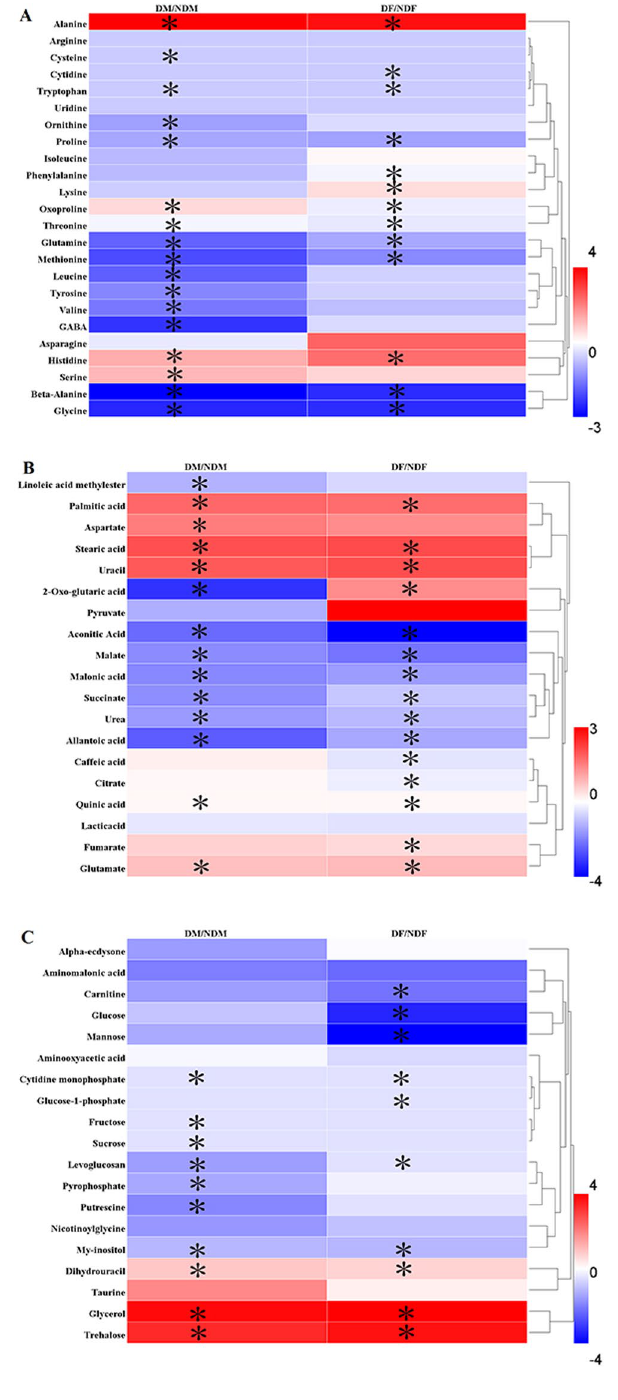
Figure 3. Comparison of the C. ciliata adults metabolome during dormancy. Heatmaps represent log2 fold change (dormant/non-dormant) of the A:amino acids, B:organic acids, C: sugars, polyols, and other metabolites of C. ciliata . Red and blue indicate up-regulation and down-regulation, respectively. DF: dormant female, NDF: non-dormant female, DM: dormant male, NDM: non-dormant male. Asterisks indicate significant differences (P < 0.05) between dormant and non-dormant